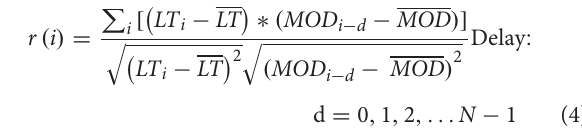
Frontiers in Marine Science |